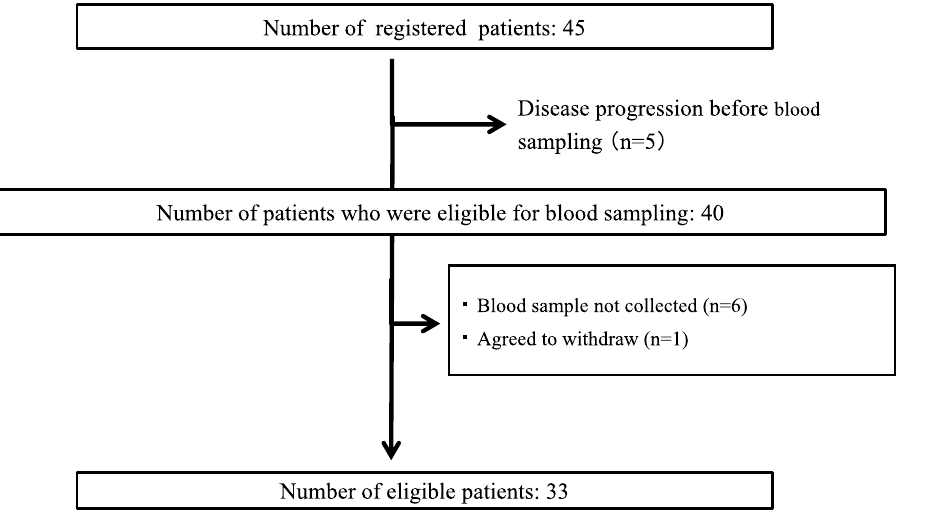
Figure 1. Flow diagram illustrating patient